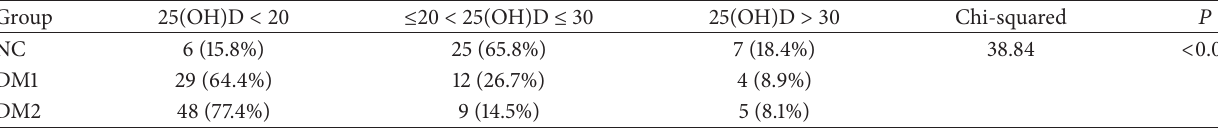
Table 2: Cases with different levels of 25(OH)D in Groups NC, DM1, and